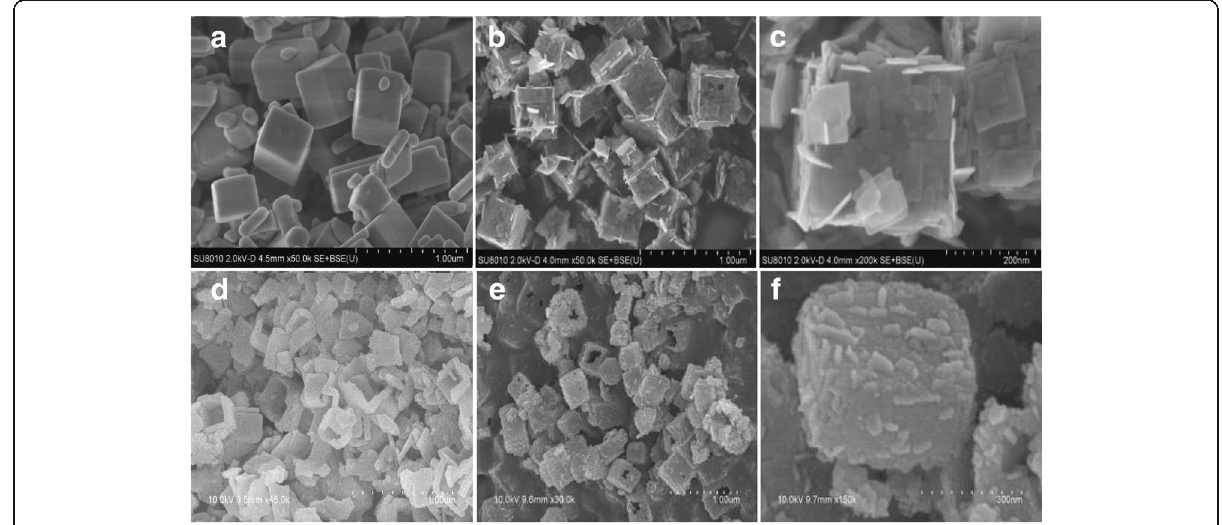
Fig. 2 SEM images of as-prepared catalysts: a TiOF 2 , b TiO 2 -HNBs, c T-1p, d T-2p, e T-3p, and f